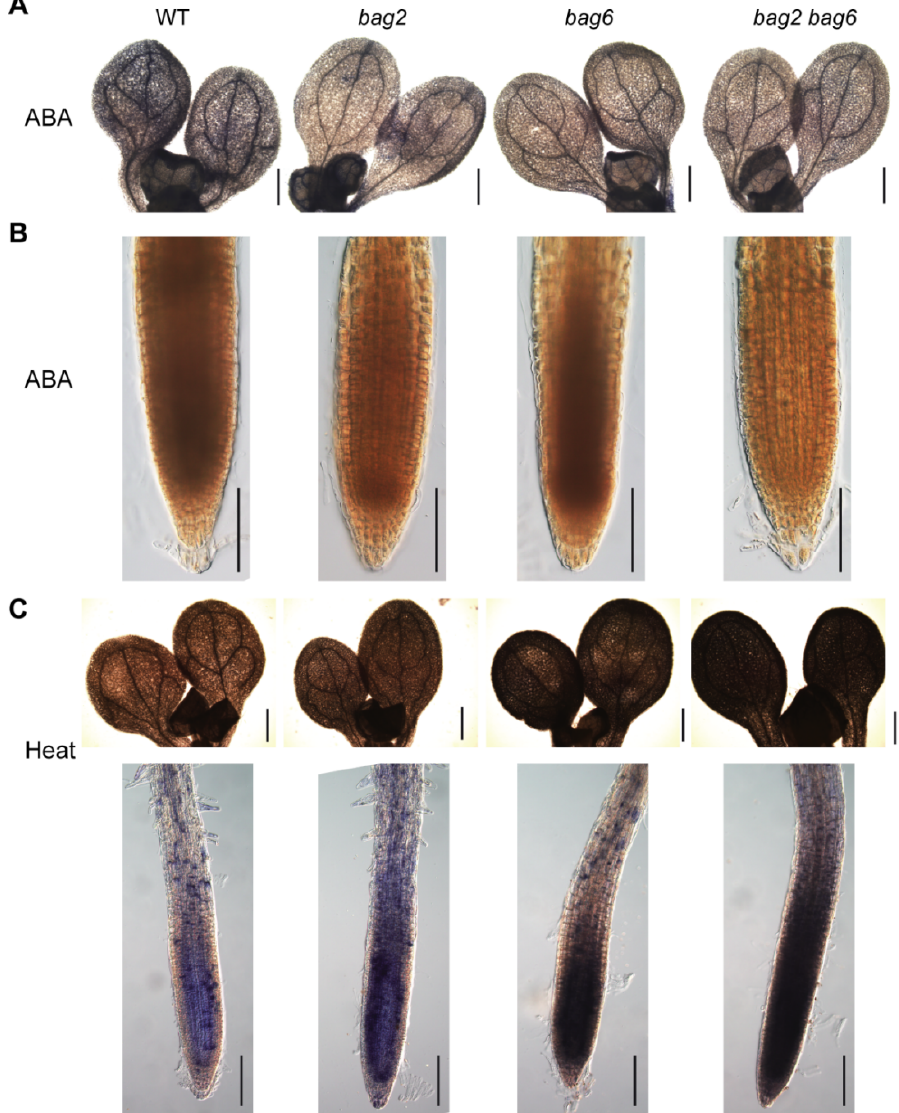
Figure 10. BAG2 and BAG6 mutation affects the ROS levels after ABA and heat treatment in Ara- bidopsis seedlings. Five-day-old seedlings were transferred to 1/2 MS agar plates supplemented with 20 μM ABA for 6 h or were treated with heat stress (37 °C) for 3 h, then were stained with NBT (staining for O 2- ) ( A , C ) or DAB (staining for H 2 O 2 ) ( B ). At least three independent experiments were performed for each analysis and 15 seedlings of each genotype were examined. Bars = 400 μm in ( A ) and in the shoot images in ( C ) and 100 μm in ( B ) and in the root images in ( C ).